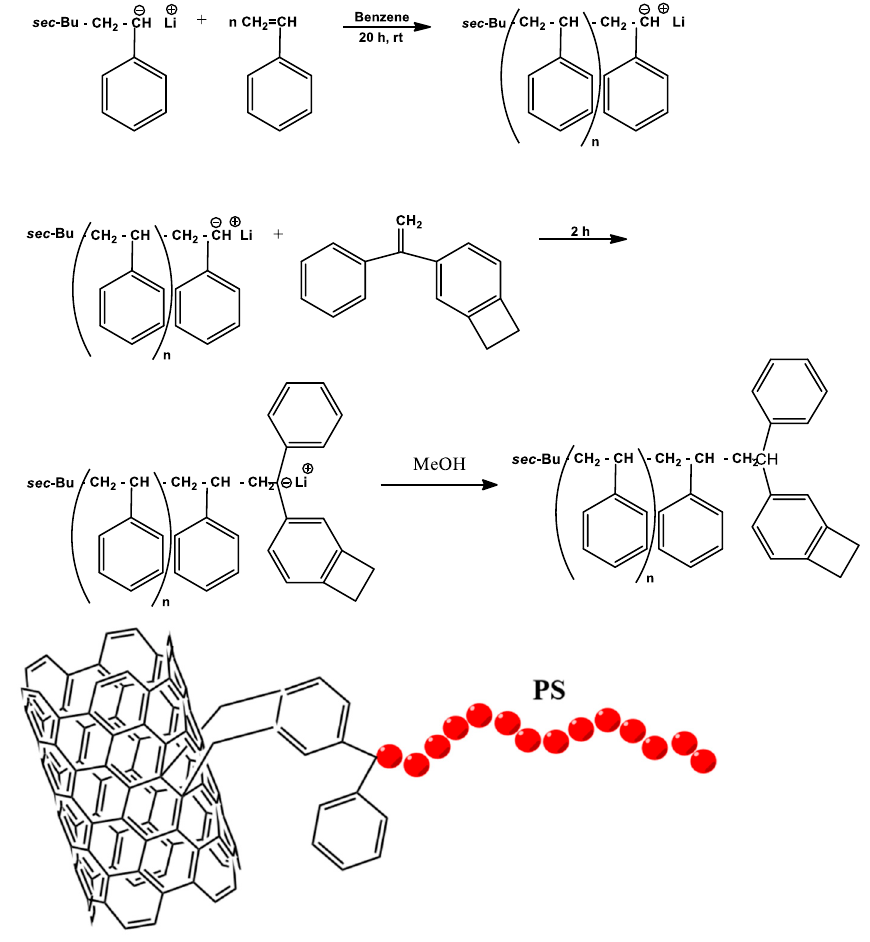
Scheme 1. Synthetic strategy for the synthesis of end-capped PS-(diphenylethylene cyclobutene